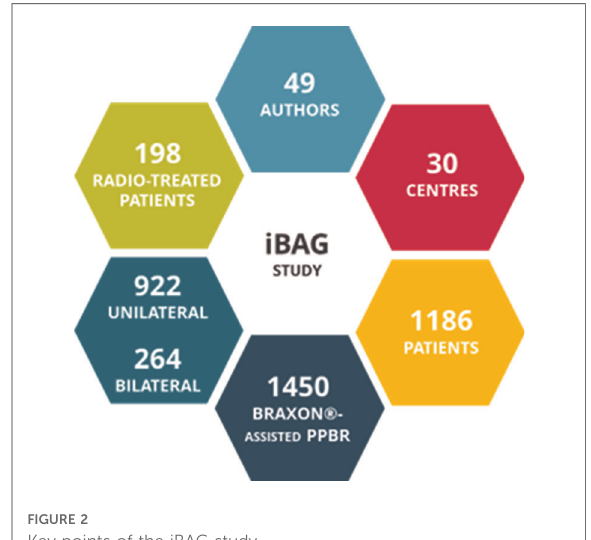
FIGURE 2 Key points of the iBAG